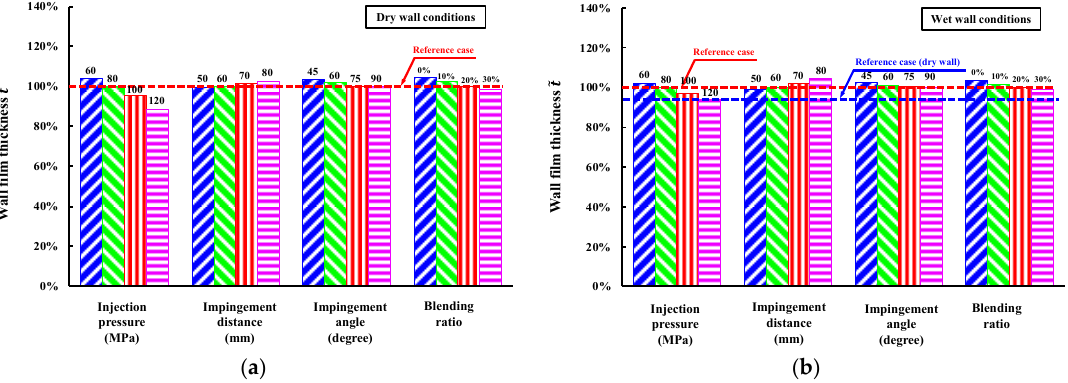
Figure 11. Variations of wall film average thickness under different experiment conditions for: ( a ) dry wall conditions; and ( b ) wet wall conditions.